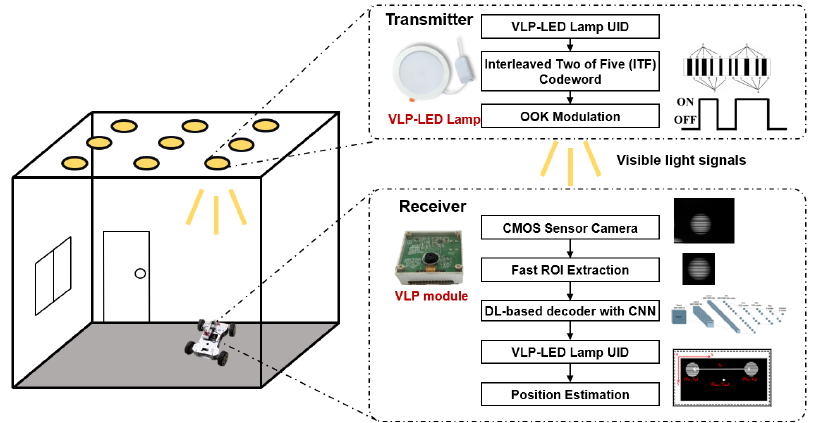
Figure 1. The proposed DL-based robust VLP